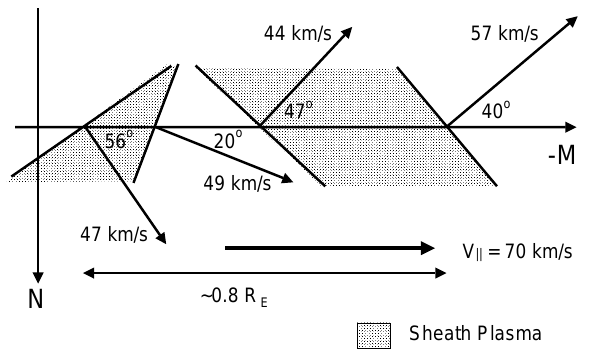
Fig. 8. A summary sketch of the inferred orientation and motion of the observed boundaries of magnetosheath electron populations shown in Fig. 7. The leading edge of the first, major enhancement, represented on right, moves duskward and Earthward at 57km s − 1 . Somewhat unexpectedly, the trailing edge of this enhancement (sec- ond from right) has a similar motion. However, the leading and trailing edges of the more minor enhancement in magnetosheath density show motion towards dusk and back out towards the mag- netopause. Note that the positions of the boundaries on the M axis are scaled according to the times of their observation, in order to represent an approximate spatial separation of these structures. The inferred motion is consistent with the entire structure having a scale size of ∼ 0.8 R E and moving duskwards across the magnetopause at ∼ 70 km s − 1